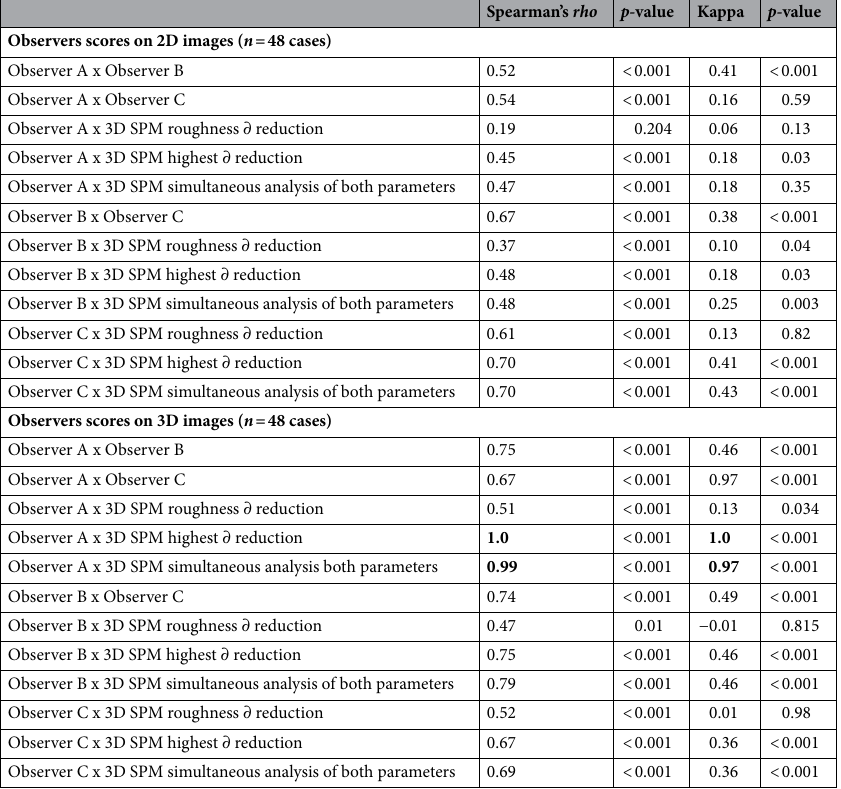
Table 4. Spearman’s rho correlation coefficient, the Kappa statistics and the descriptive level ( p -value) based on the ordinal data (scores). x = versus.